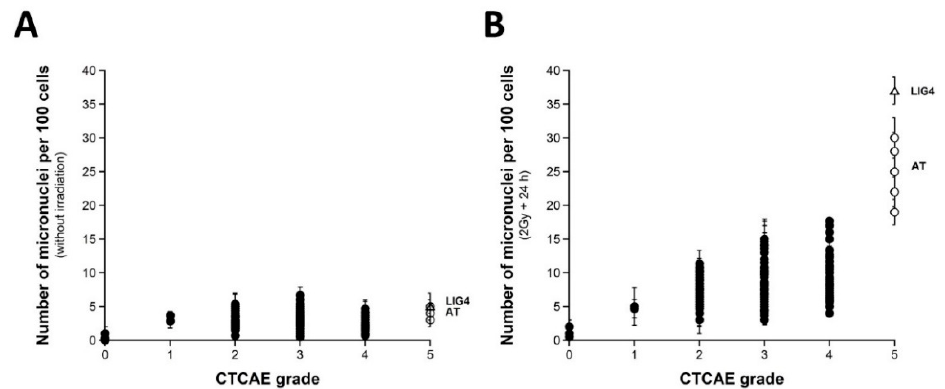
Table 2 . Discrimination power of the major molecular radiosensitivity endpoints * .